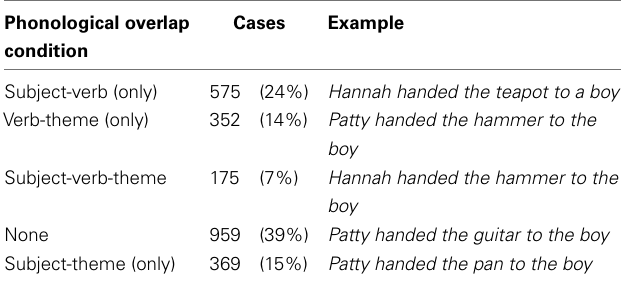
Table 1 |Types of phonological overlap observed in the